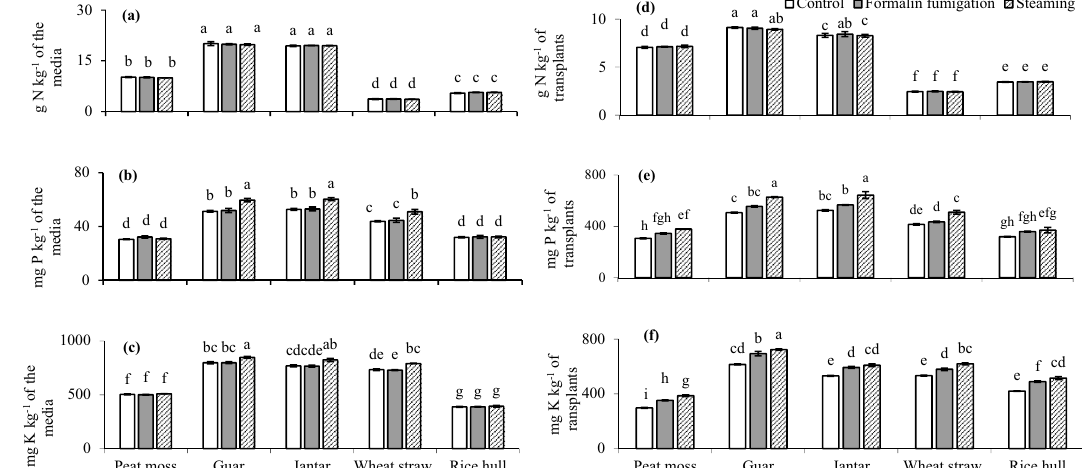
Figure 4. Relative concentrations of nutrients in the media and muskmelon seedlings under different sanitation techniques. Concentrations of various nutrients: ( a ) total N; ( b ) P; ( c ) K in the media; ( d ) N; ( e ) P and ( f ) K in muskmelons transplants have been represented. All the values are means ± S.E of three replicates, whereas case letters indicate significant differences among the treatments at p ≤ 0.05